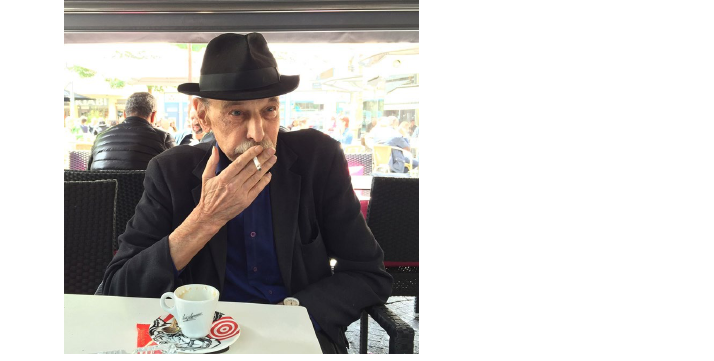
Figure 12 Pascal Schönig in Metz, France, in 2015, near Unité d'Habitation in Briey-en-Forêt where he lived after his retirement. (Photo by the Author) https://www.aaschool.ac.uk/obituaries/pascal-schoning-1939-2016